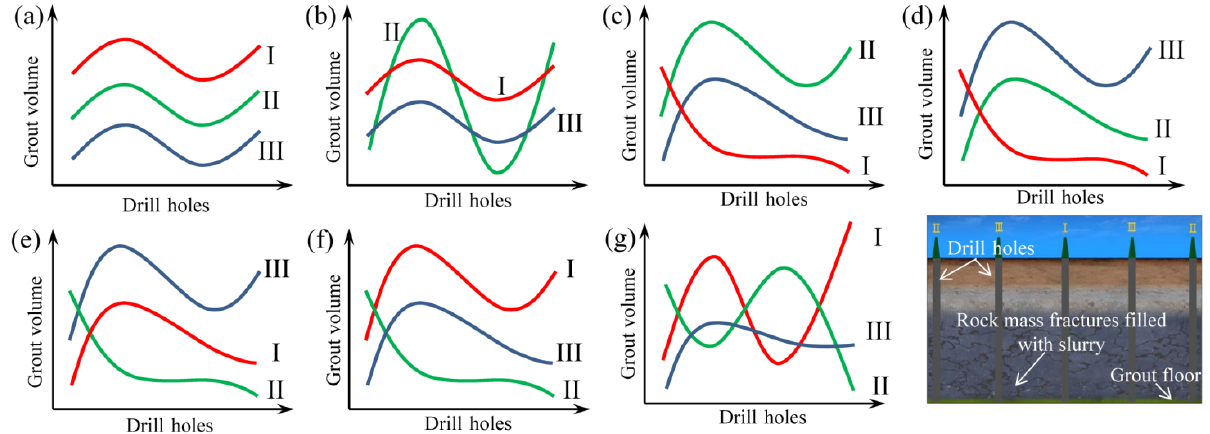
Figure 3. Relationship curves of unit grouting quantity of I-, II-, and III-sequence holes: ( a ) I > II >